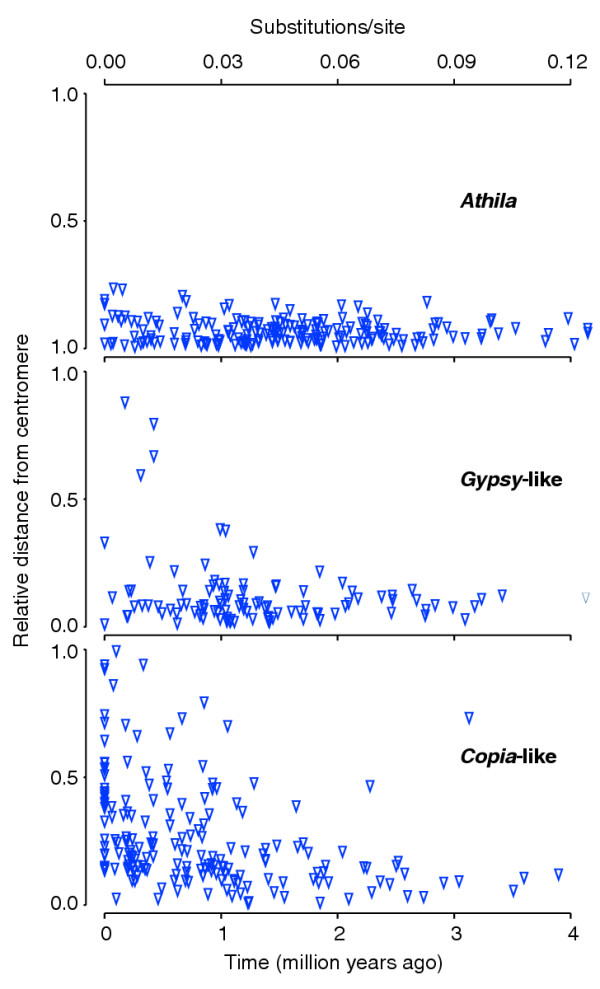
Relationship between age and physical distributions of complete elements. Insertions into the short arms of chromosomes II and IV were excluded for clarity. These arms contain extensive heterochromatin away from the centromeres, in nucleolar-organizing regions that juxtapose their telomeres, and in a knob [14]. In addition, their short length implies that the pericentromeric heterochromatin, which spans around 1-1.5 Mbp in each arm [68], corresponds to a substantially higher fraction of their total length than in the other eight arms.